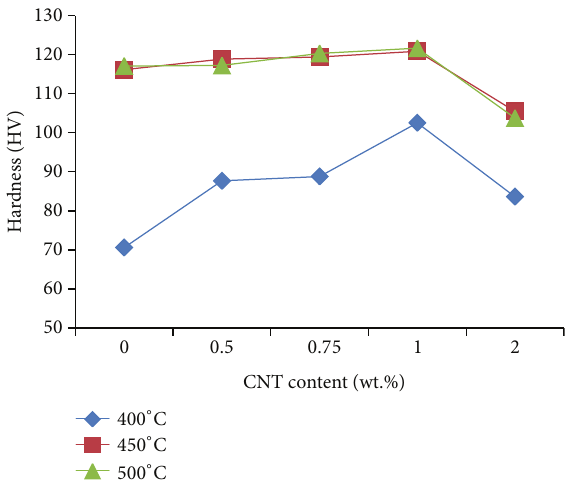
Figure 10: Microhardness of CNT reinforced Al2124 nanocompos-